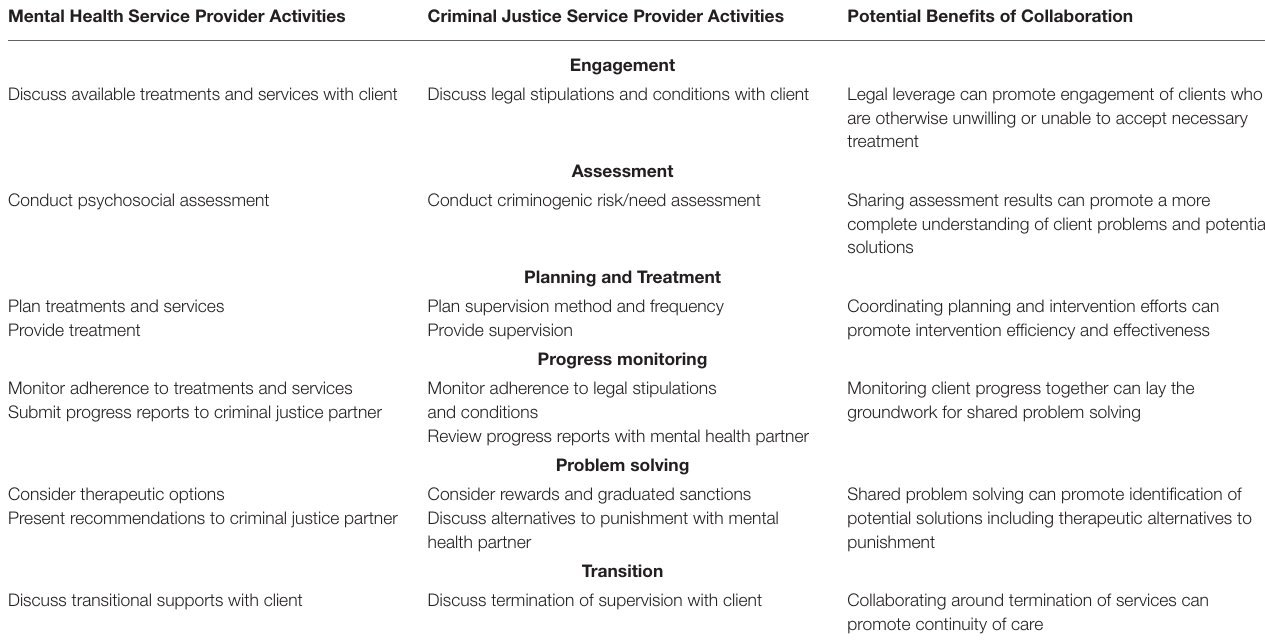
TABLE 1 | A collaborative framework for serving justice-involved adults with serious mental